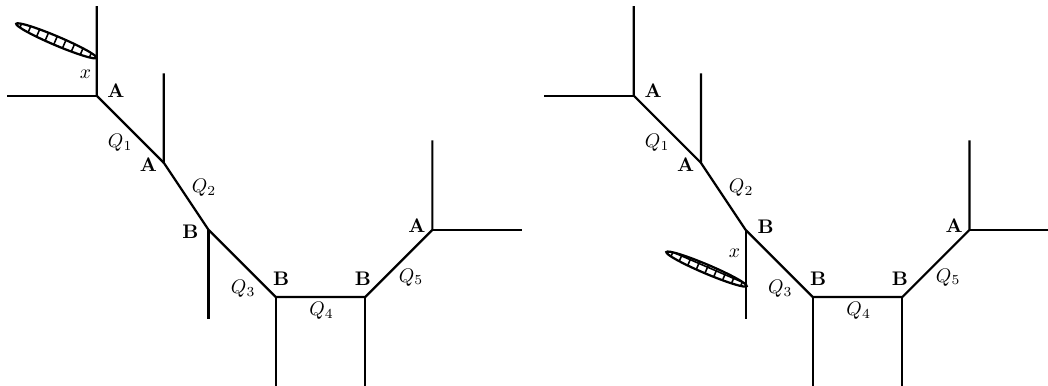
Figure 1: Examples of a strip geometry with branes on external legs. Kähler param- eters are denoted by Q , each vertex is of type A or B , and the brane modulus is i denoted by x